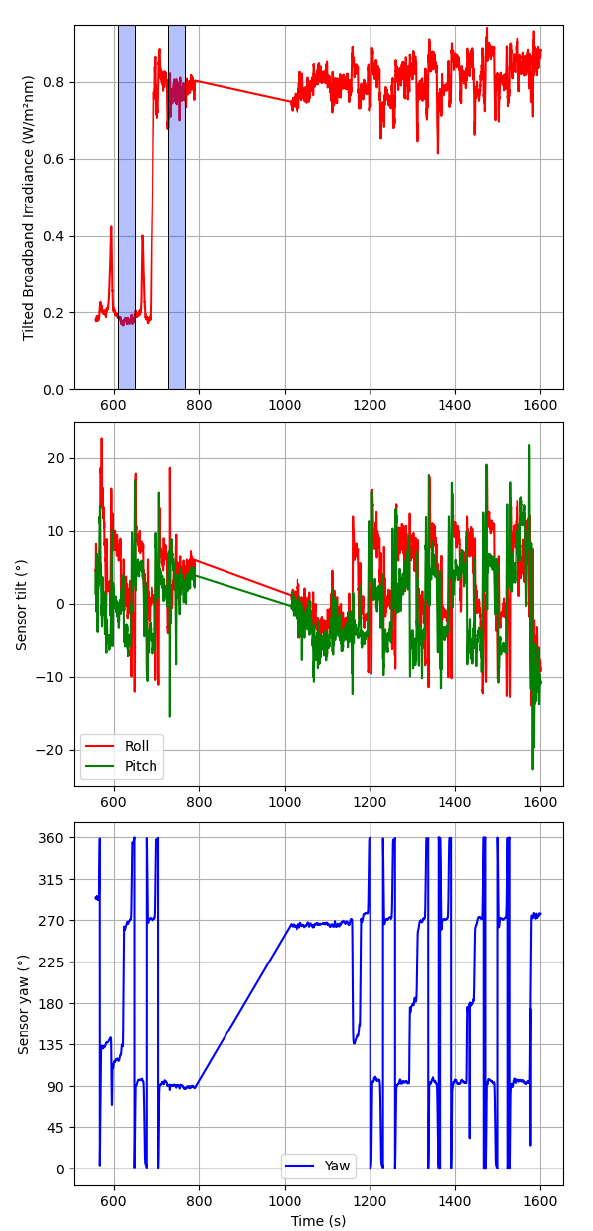
Figure 4 . (Top) Time series of not-tilt-corrected irradiances as measured by the AIRS spectrometer during the flight experiment. The blue boxes highlight the low and high irradiance periods used in solving the direct and diffuse spectral endmembers. (Middle) Irradiance sensor roll and pitch angles as measured by the AIRS IMU. (Bottom) Irradiance sensor yaw angle.